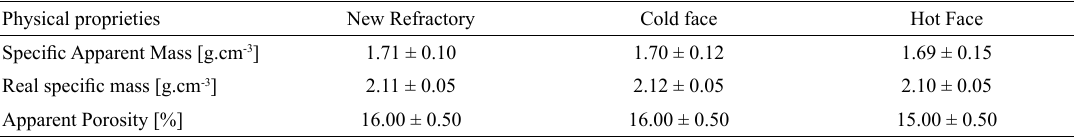
Table 2. Physical proprieties of the samples collected from Intermediated Hearth Region with standard deviation.